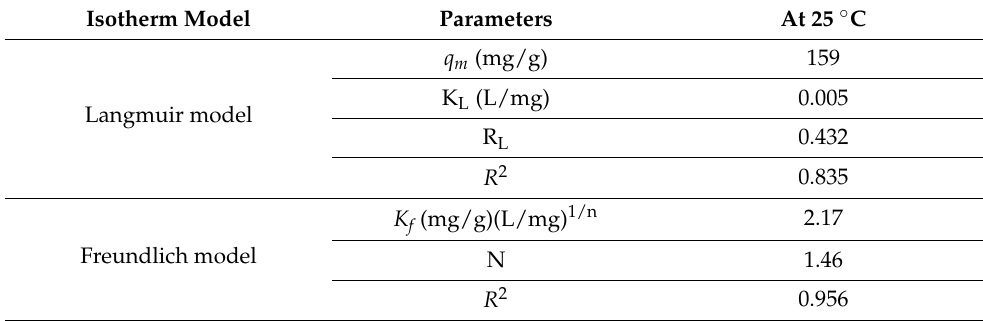
Figure 14. Adsorption isotherm plots for phenol adsorption on IL–agar–alginate beads using ( a ) Langmuir and ( b ) Freundlich models at 25 ◦ C. Table 3. Isotherm model parameters for the adsorption of phenol onto the beads at 25 ◦